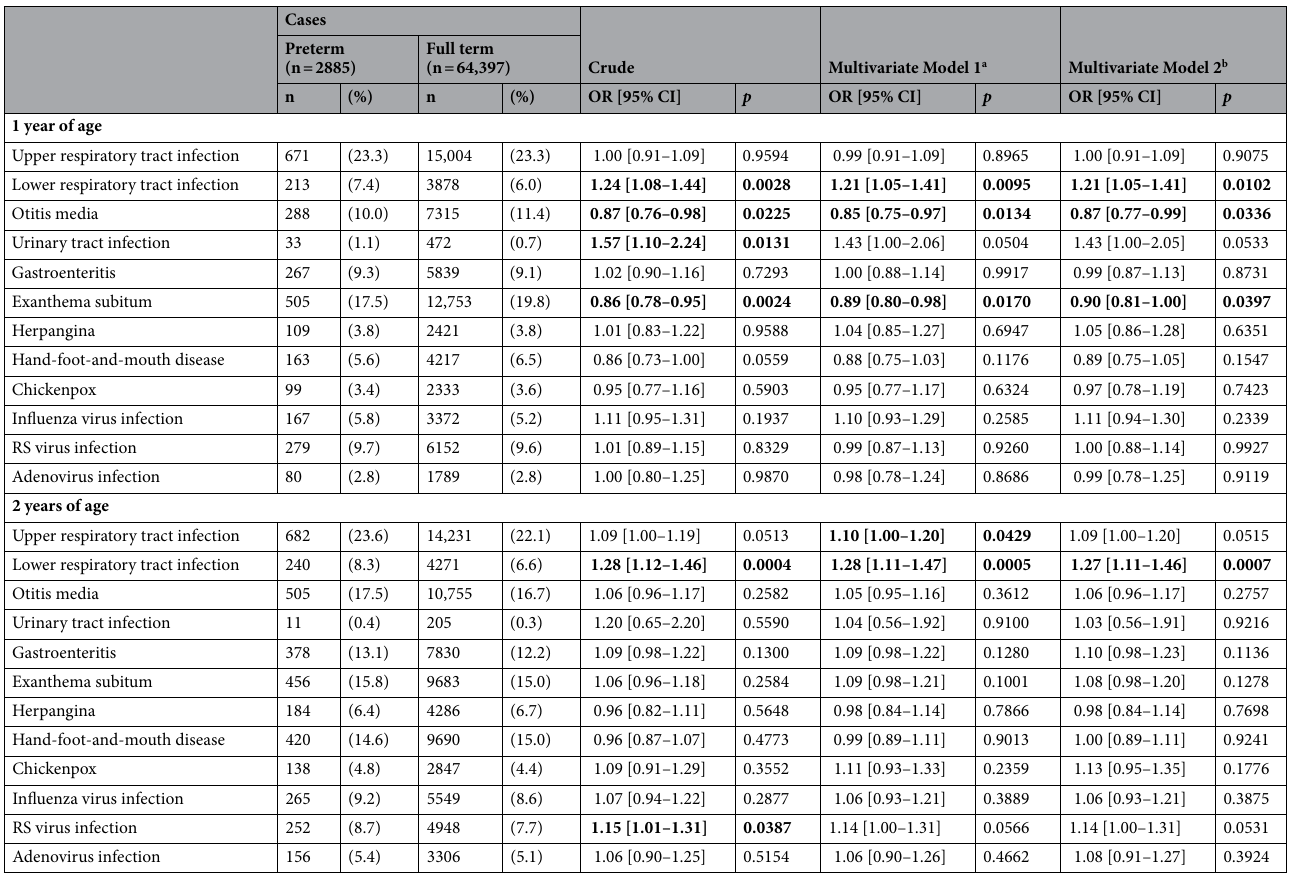
Table 2. Associations between preterm birth and infections at 1 year and 2 years of age. Boldface indicates significance. a Adjusted for maternal age, pre-pregnancy body mass index, parity, history of maternal allergy, history of any physical disease, marital status, employed, highest education level, annual household income, alcohol intake, smoking history, physical activity. b Adjusted for all the covariates in Model 1 and feeding methods and attending a childcare facility. n = 67,282.